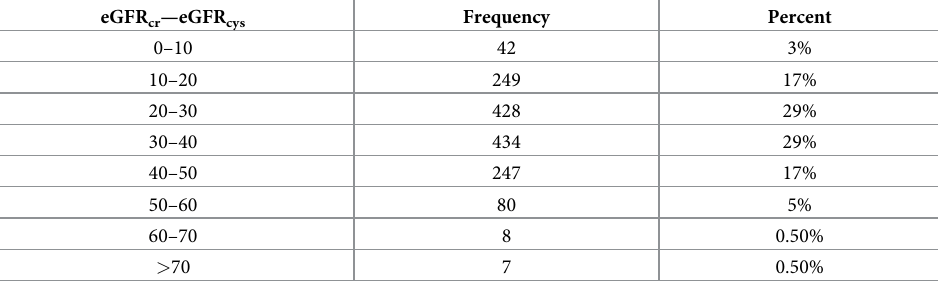
Table 4. Distribution of eGFR discrepancy among those reclassified to CKD (i.e eGFRcr � 60 & eGFRcys < 60).